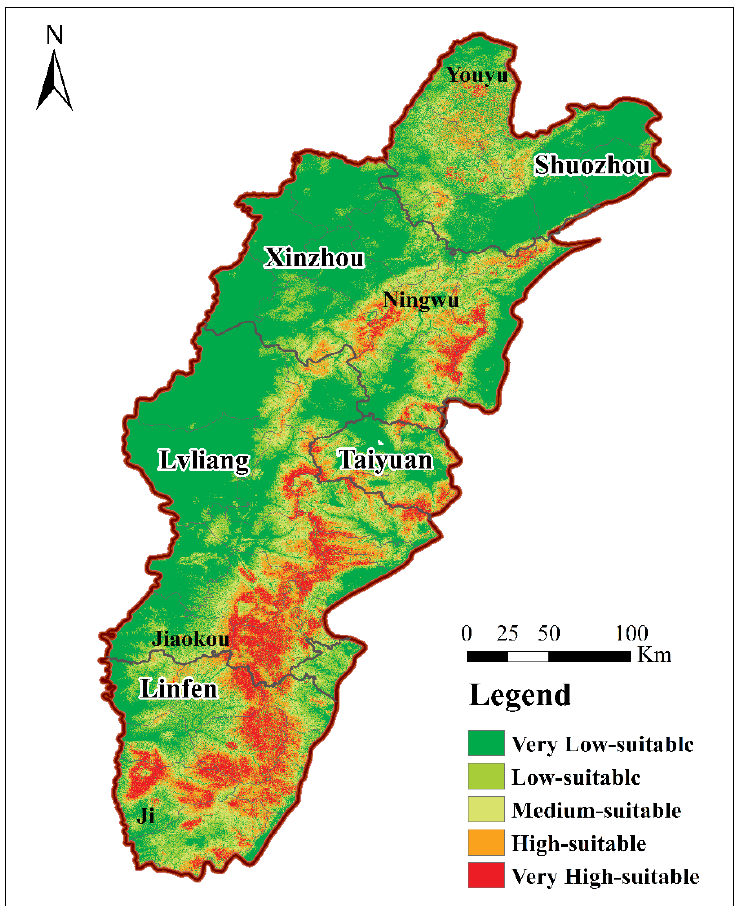
Figure 6. Map of habitat suitability of forests in Lvliang Mountain.